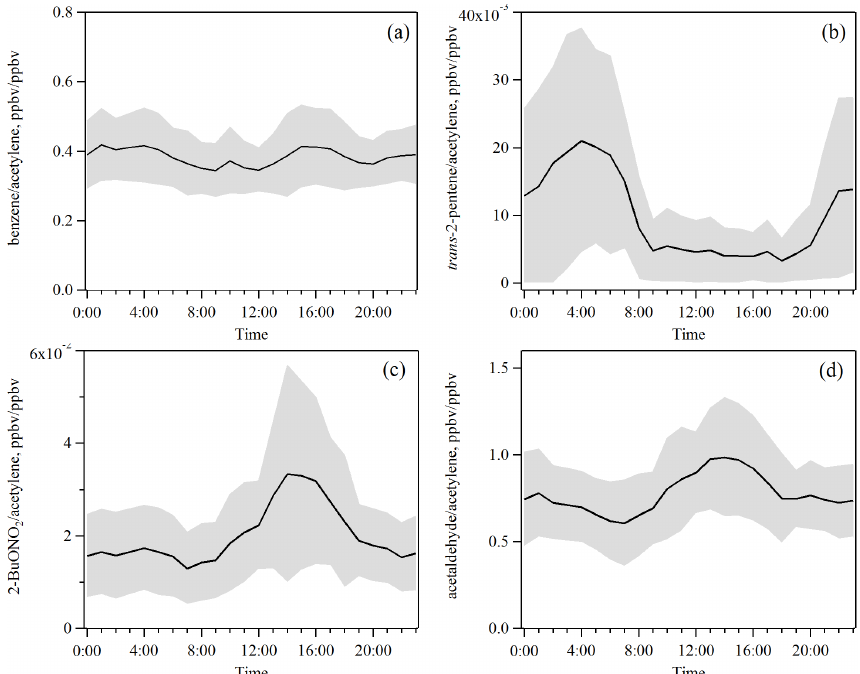
Figure 3. Diurnal variations in hourly average ratios of (a) benzene/acetylene, (b) trans -2-pentene/acetylene, (c) 2-BuONO 2 /acetylene, and (d) acetaldehyde/acetylene, measured during August–September 2011 at the PKU site. Grey areas represent one standard deviation from the hourly average